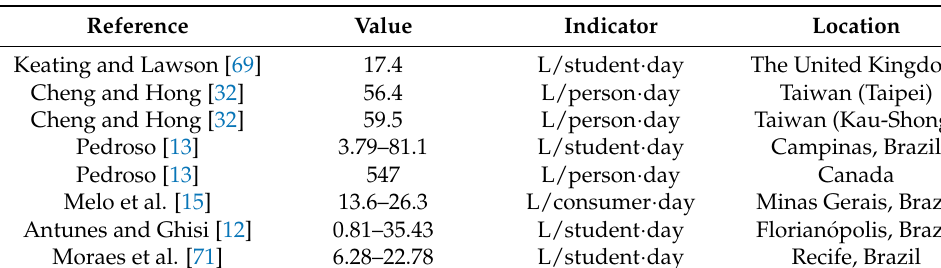
Table 4. The water consumption variability in schools.